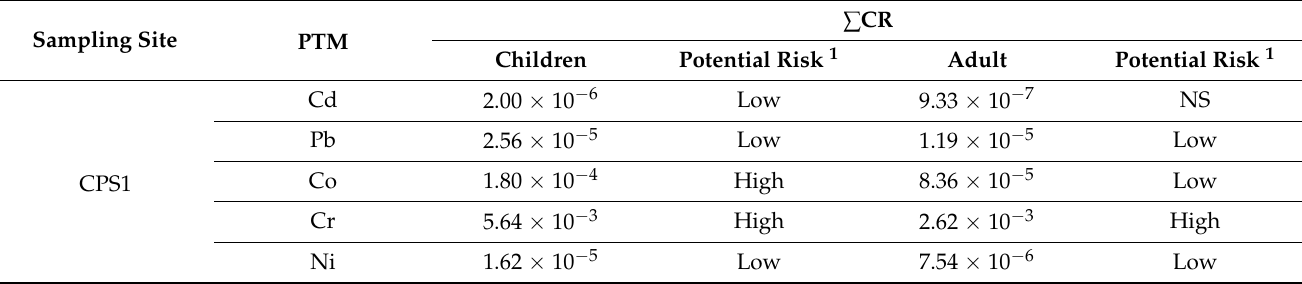
Table 5. Indices of carcinogenic risks (CR) for the PTM Cd, Pb, Co, Cr, and Ni, including indication of potential carcinogenic health